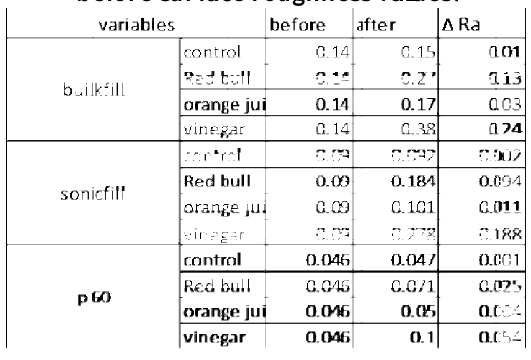
before surface roughness values.